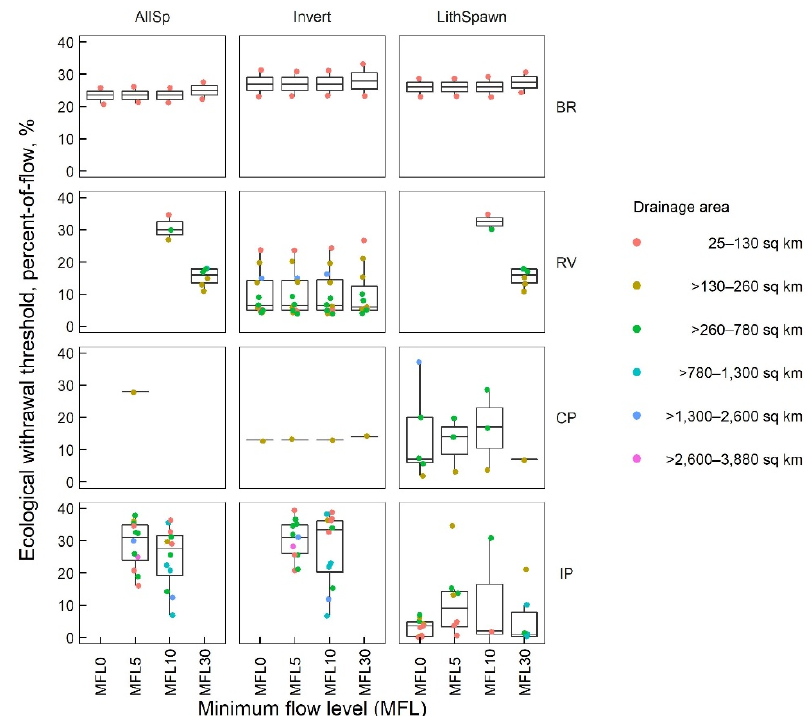
Figure 8. Boxplots of predicted ecological withdrawal threshold under percent-of-flow (POF) withdrawal scenarios among select fish groups and minimum flow levels (MFLs) for Blue Ridge (BR), Ridge and Valley (RV), Cumberland Plateau (CP), and Interior Plateau (IP) ecoregions. Boxes represent the 25th and 75th quantile; center line represents the median (50th percentile). Points are threshold values for individual stream sites and are color coded by drainage-area size. Results for all fish groups are illustrated in Figure S18.